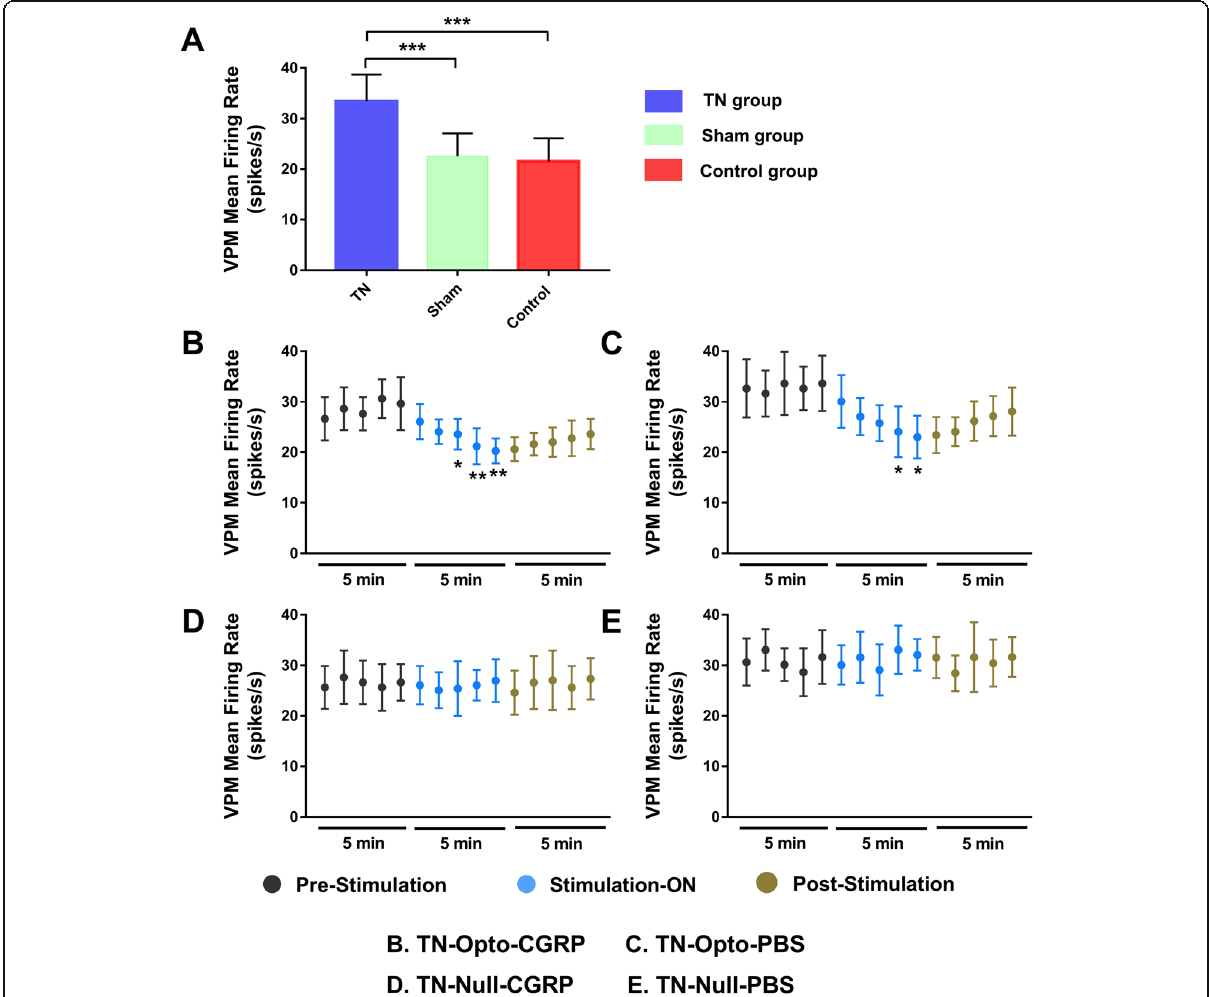
Fig. 5 Electrophysiological findings for VPM thalamic output due to optogenetic stimulation of the motor cortex. a Evoked firing rates in VPM neurons in TN animals versus sham and control animals (***, p < 0.001, significant difference determined using unpaired t -tests). b , c In vivo recordings of the VPM thalamus from TN-Opto animals. b Findings for the TN-Opto-CGRP group. c Findings for the TN-Opto-PBS group. Decrease in firing output (spikes/s) were observed during the stimulation ON period. d , e No changes in firing rates of VPM thalamus were observed in the TN-Null-CGRP and TN-Null-PBS groups, respectively (two-way analysis of variance (ANOVA) *, p < 0.05; **, p <